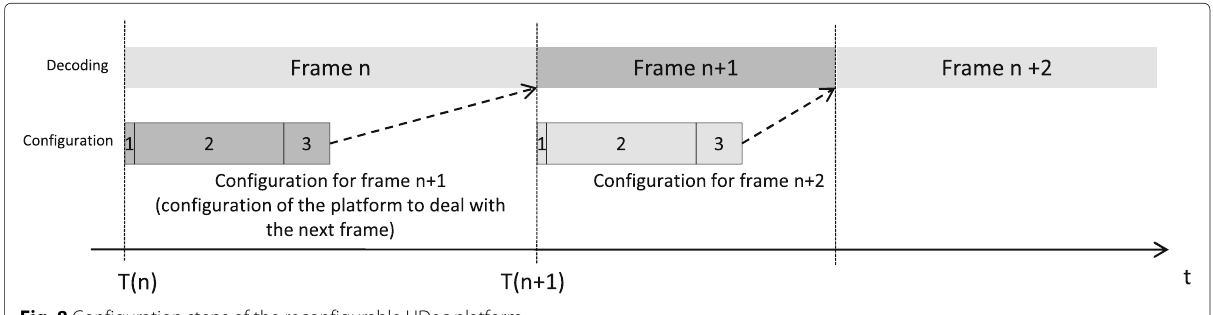
Fig. 8 Configuration steps of the reconfigurable UDec